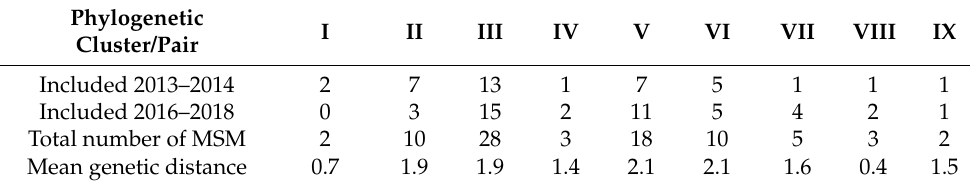
Figure 1. An overview of the clusters and transmission pairs ( I – VIII ) with a genetic distance threshold <3%. The circles represent HCV infections included prior to the widespread use of DAA therapy (all in HIV-positive MSM). The triangles represent HCV infections among HIV-positive and star among HIV-negative MSM after DAA introduction. The size of the nodes represents the number of sequences to which that particular node was phylogenetically linked. The colours represent the centres where patients were diagnosed with HCV (dark blue = Haarlem, dark green = The Hague, grey = Arnhem, light blue = Amsterdam, light green = Antwerp (Belgium), pink = Maastricht, orange = Utrecht, and red = Rotterdam) The clusters consisted only of study samples and did not include any of the control samples, which mostly originated from other European countries and the United States. The figure is established using Microbe Trace [20]. Table 1. An overview of the clusters and transmission pairs obtained with maximum likelihood phylogenetic reconstruction N = 82 sequences clustered in a cluster or pair. The other seven were not linked to any of the sequences in our set or reference set. The samples are divided in the ones included between 2013 and 2014 prior to the widespread use of the direct-acting antivirals in 2015 and